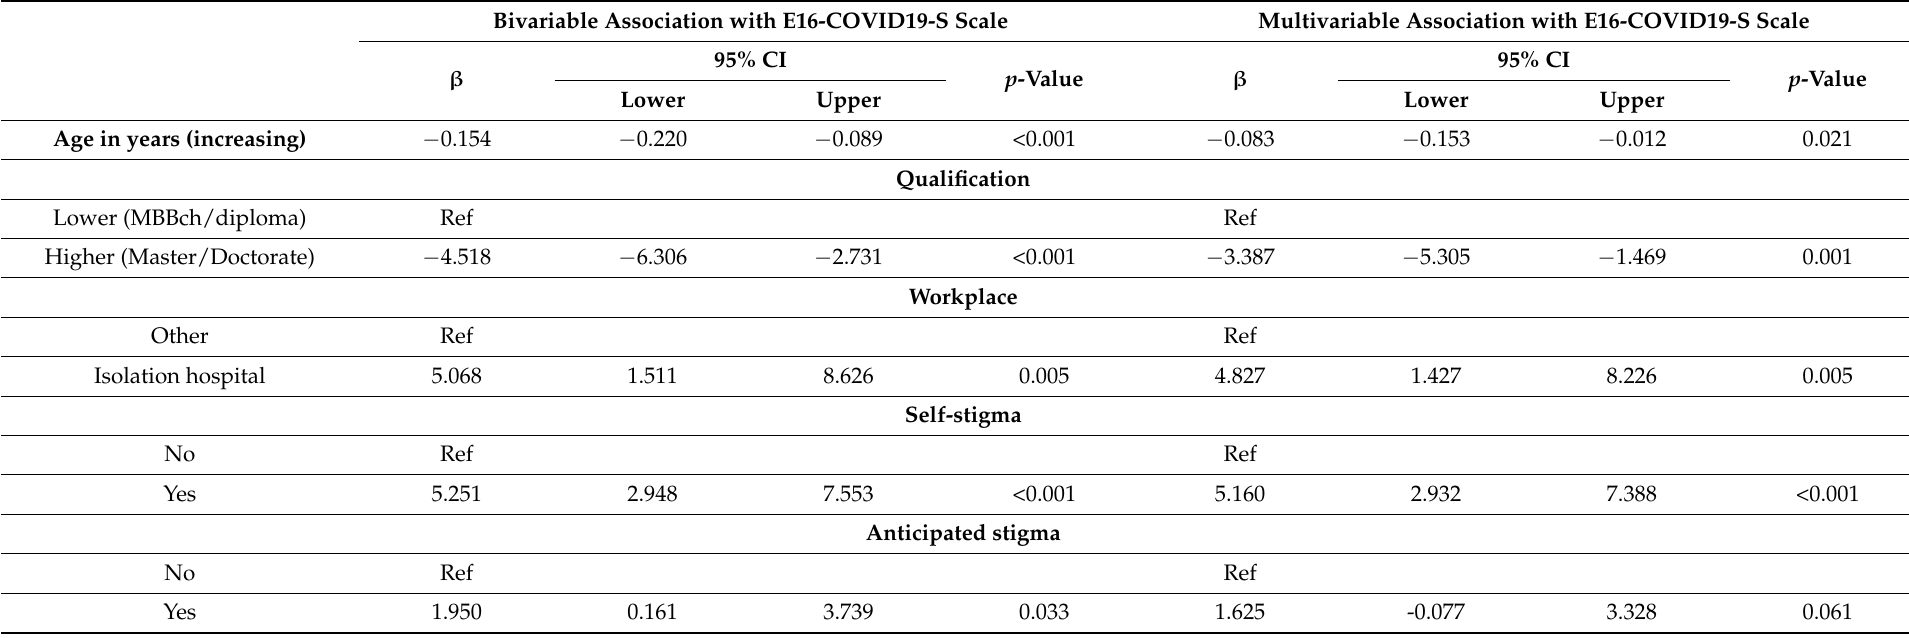
Table 5. Regression analyses of the factors associated with E16-COVID19-S scale. Bivariable Association with E16-COVID19-S